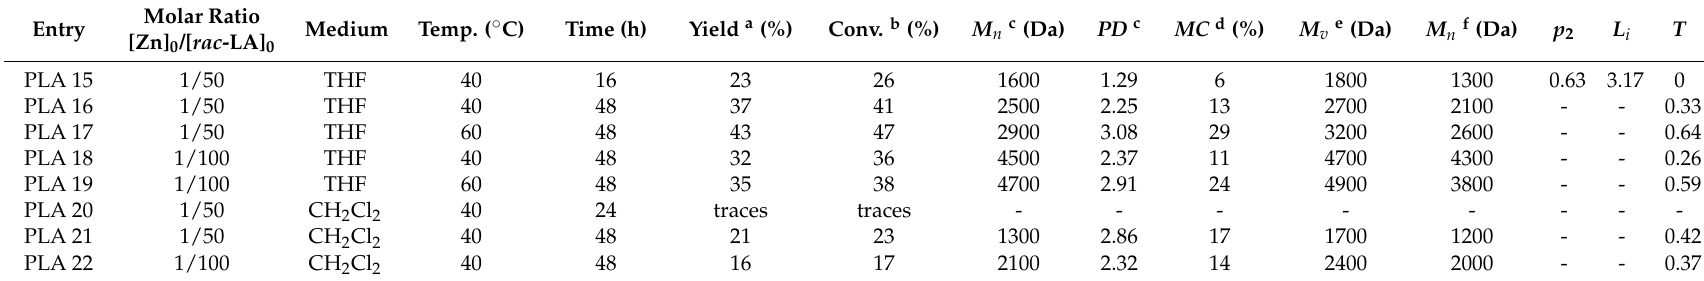
Table 2. Ring-opening polymerization of rac -LA in tetrahydrofuran and dichloromethane in the presence of ZnEt 2 /GAc catalytic